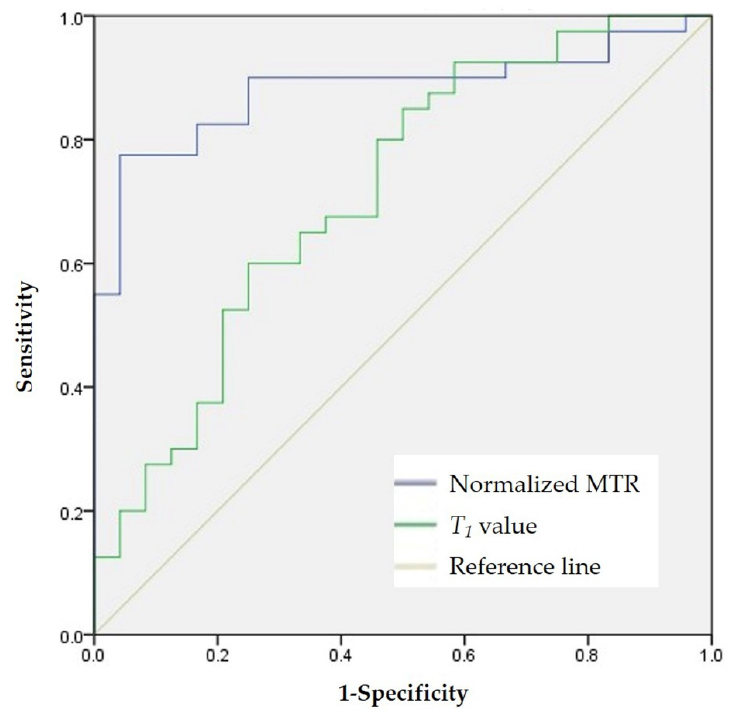
Figure 3. ROC analysis for differentiating none-to-mild fibrosis from moderate-to-severe fibrosis. ROC analysis shows that T 1 value (AUC = 0.716, p = 0.004) has moderate accuracy in distinguishing none-to-mild fibrosis from moderate-to-severe fibrosis in all 64 specimens, while normalized MTR (AUC = 0.881, p < 0.001) shows good accuracy in differentiating the degree of bowel fibrosis; the difference between the T 1 value and normalized MTR is significant ( z = − 2.037, p = 0.042). AUC = area under the curve; MTR = magnetization transfer ratio; ROC = receiver operating characteristic; T 1 = longitudinal relaxation time.